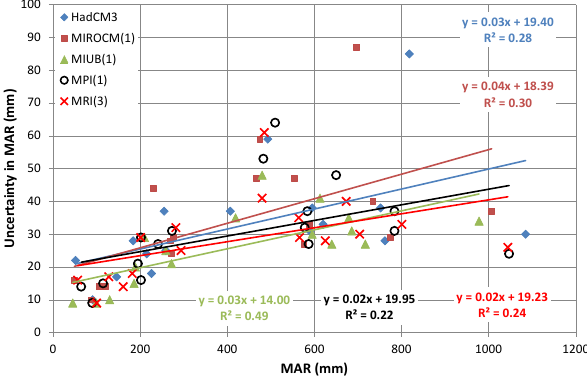
Figure 11. Within-GCM uncertainty (mmyr − 1 ) in standard devi- ation of annual runoff versus standard deviation of annual runoff based on 100 PERM runs using replicates of monthly precipitation and temperature (1965–1994, 20C3M) as input from five